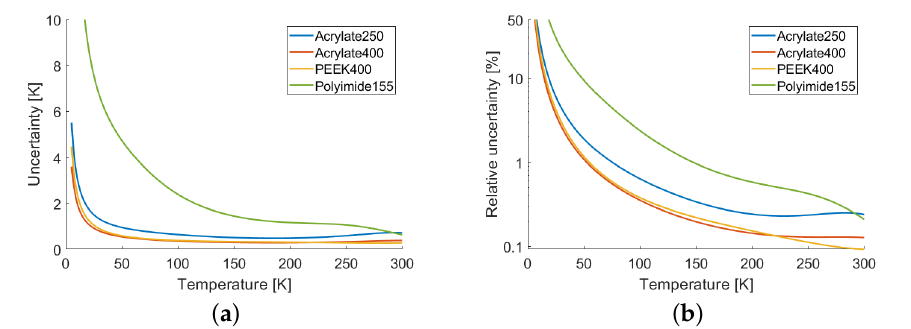
Figure 7. ( a ) Absolute uncertainties and ( b ) relative uncertainties, in log